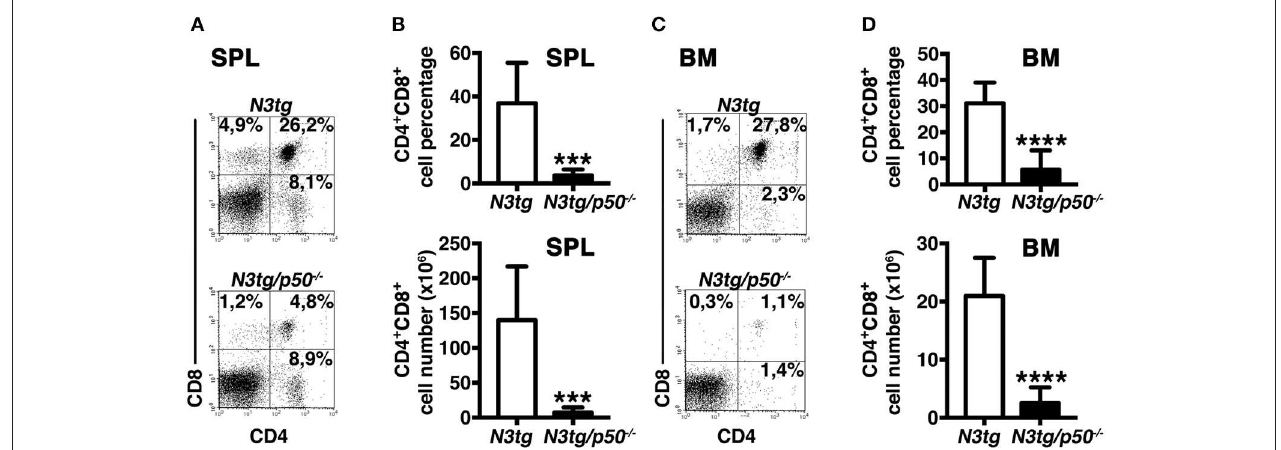
FIGURE 2 | Reduced expansion of CD4 + CD8 + (DP) T cells in N3tg/p50 − / − mice. Representative dot plots showing CD4 vs. CD8 distributions in the spleen (A) and BM (C) of N3tg/p50 − / − vs. N3tg mice at 8–9 weeks of age, as assessed by flow cytometry. Numbers inside each cytogram represent the percentages of different cell subsets. (B) Percentages and absolute numbers of DP T cells in the spleen (SPL) of N3tg/p50 − / − vs. N3tg mice, measured as in (A) . (D) Percentages and absolute numbers of DP T cells in the bone marrow (BM) of N3tg/p50 − / − vs. N3tg mice , measured as in (C) . In (B,D) the values are presented as mean ± SD of five